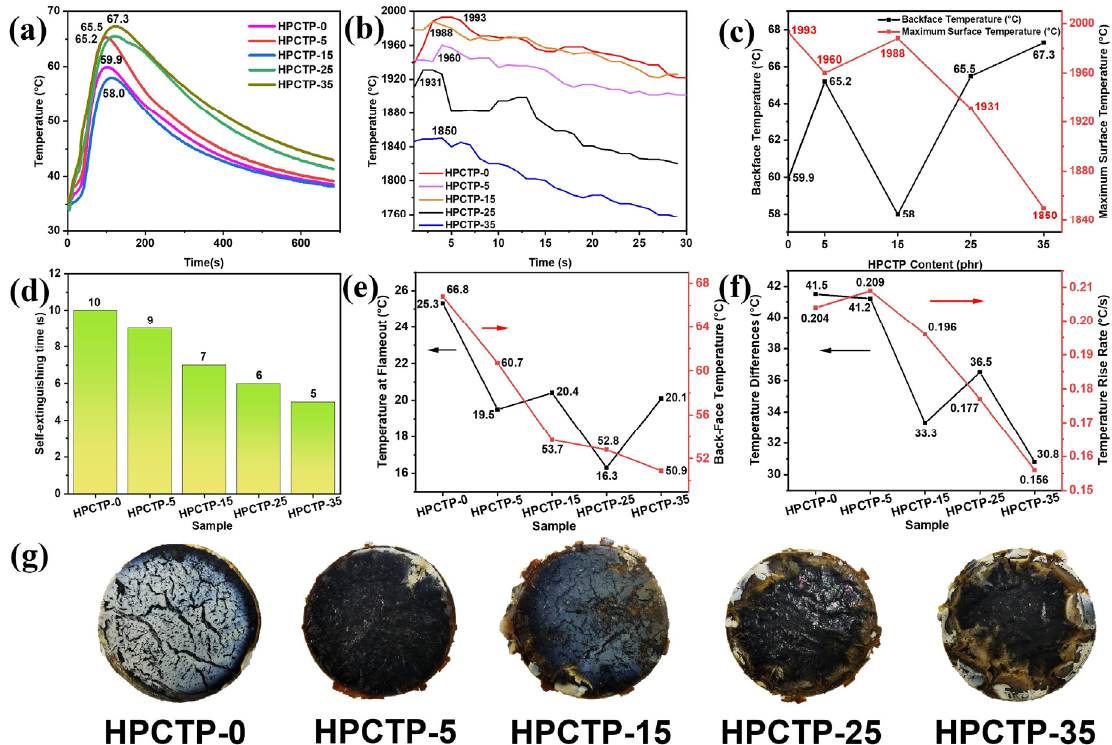
Figure 5. Thermal insulation-related performance parameters of HPCTP-containing EMVSR com- posites: ( a ) back-face temperature curve under 4 MW/m 2 heat flow; ( b ) surface temperature curve recorded during back-face temperature measurement under 4 MW/m 2 heat flow; ( c ) the relationship between maximum back-face temperature and maximum surface temperature; ( d ) self-extinguishing time of the flame on the surface of sample after ceasing oxyacetylene ablation experiments; ( e ) ceasefire temperature and maximum back-face temperature under 0.2 MW/m 2 heat flow; ( f ) back-face temperature difference and back-face temperature rise rate under 0.2 MW/m 2 heat flow; ( g ) optical images of the samples after butane ablation tests.